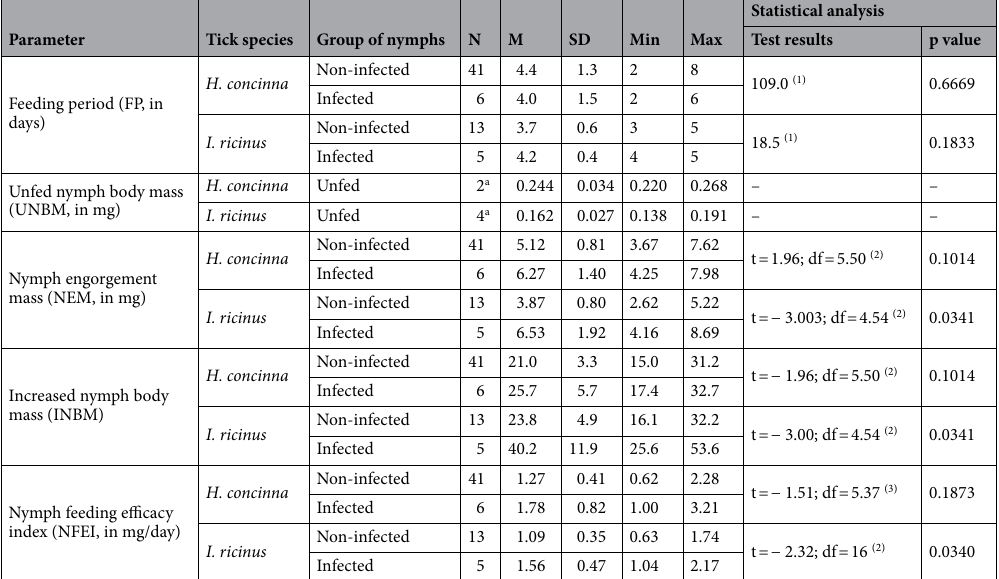
Table 2. Comparison of the course of the parasitic phase of Ixodiphagus hookeri -infected and non-infected Haemaphysalis concinna and Ixodes ricinus nymphs. a Number of pools of nymphs with 10 specimens in each involved in the study, 1 Mann-Whitney U test, 2 test T, 3 Cochran-Cox test, N—number of nymphs involved in the study, M—mean, SD—standard deviation, Min—minimum, Max—maximum.